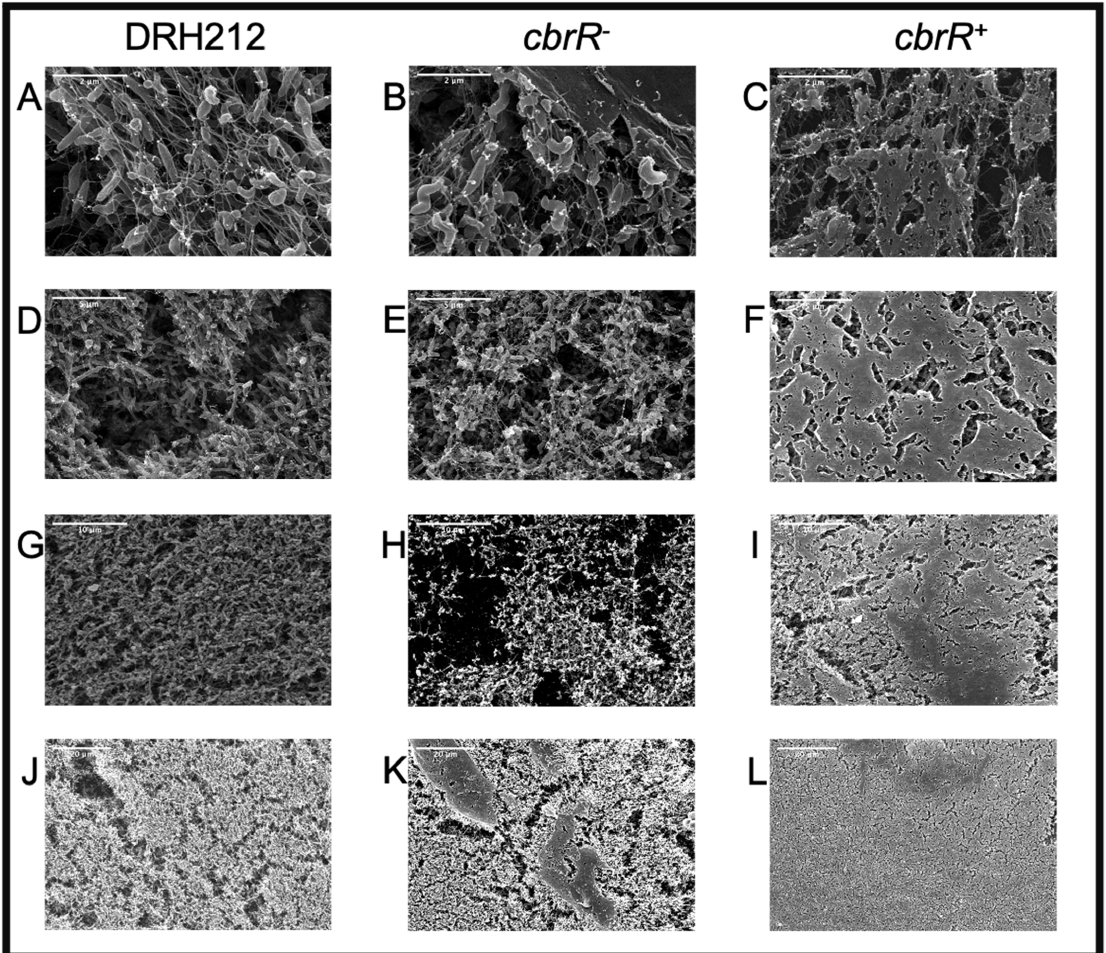
Figure 8. Robust biofilm formation is seen in wild type and cbrR − but is absent in cbrR + . SEM images at different magnifications (25,000×: A – C ; 10,000×: D – F ; 5000×: G – I ; 2000×: J – L ) of coverslips propped in C. jejuni inoculated biphasic cultures for 72 h. Images show abundant biofilm formation in DRH212 ( A , D , G , J ) and cbrR − ( B , E , H , K ) cells, whereas reduced accumulation of biomass is seen in cbrR + ( C , F , I , L ).